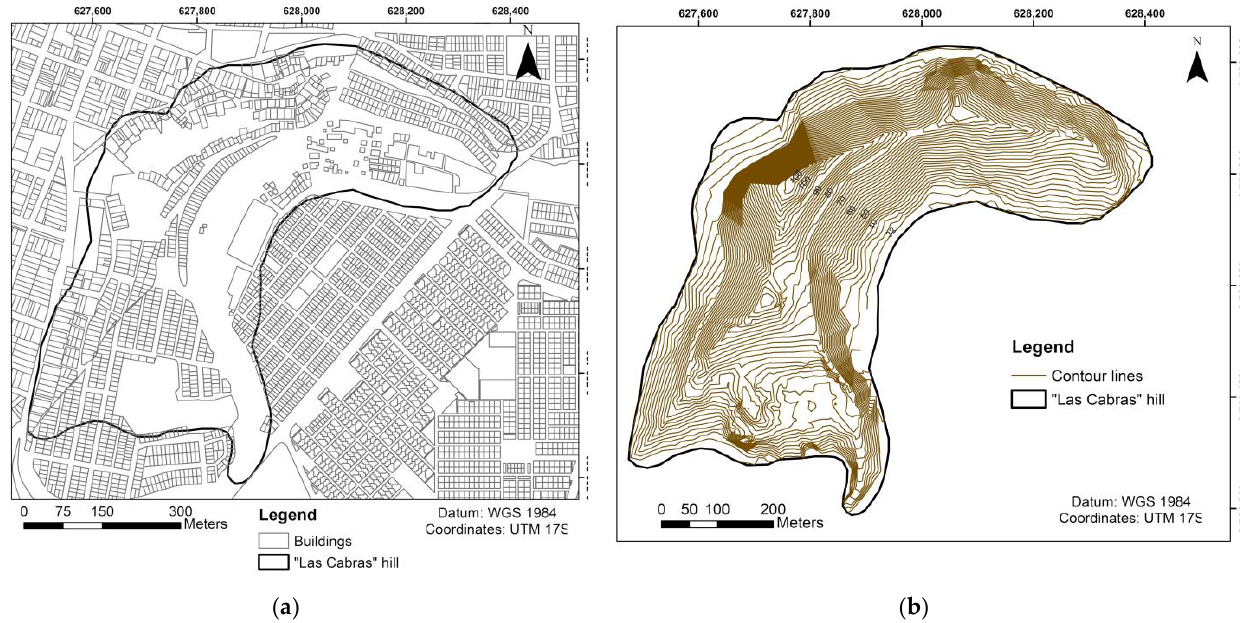
Figure 5. ( a ) Map of housing in the study area. ( b ) Detailed topography of the study area.